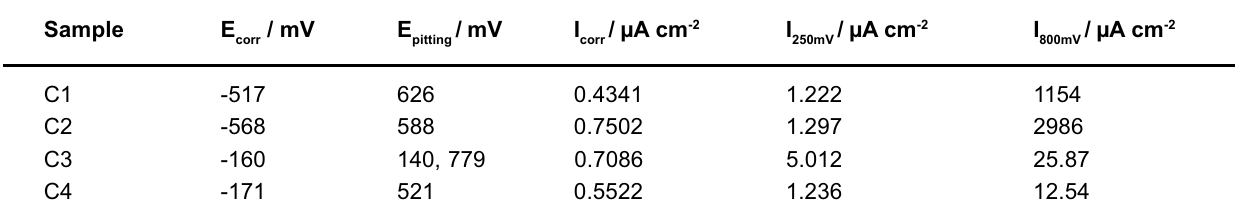
TABLE 3- Potential and current values obtained from potentiodynamic the polarization curves of Ti/suprastructure couples